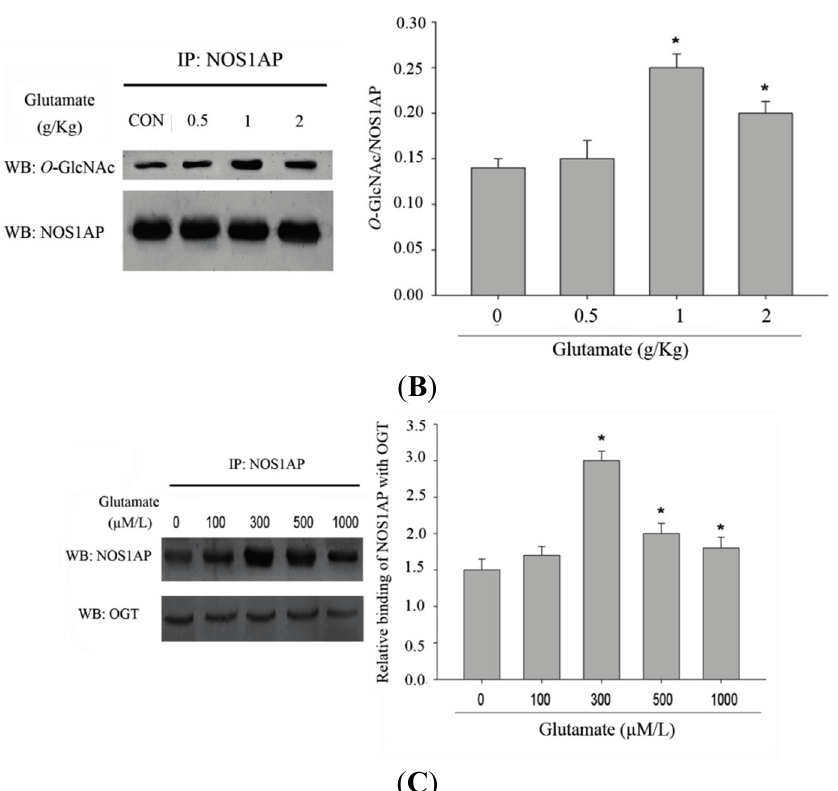
Figure 4. O -GlcNAc modification of NOS1AP was increased during glutamate-induced excitotoxicity. ( A ) PC12 cells were incubated with glutamate culture medium at concentrations of 0, 100, 300, 500, 1000 μ M/L for 12 h, separately. The same amounts of NOS1AP were immunoprecipitated and immunoblotted for O -GlcNAc; The data are mean ± SEM. ( * p < 0.05, significantly distinct from the group without glutamate treatment); ( B ) SD rats were treated with intraperitoneal injection of glutamate by 0.5, 1, 2 g/kg. The control group was treated with same volume of saline. After 2 h, NOS1AP was immunoprecipitated from brain tissue and immunoblotted for O -GlcNAc. The data are mean ± SEM. ( * p < 0.05, significantly distinct from the control group) and ( C ) PC12 cells were incubated with glutamate culture medium at concentration of 0, 100, 300, 500, 1000 μ M/L for 12 h separately. Same amounts of OGT were immunoprecipitated and immunoblotted for NOS1AP. The data are mean ± SEM. ( * p < 0.05, significantly distinct from the group without glutamate